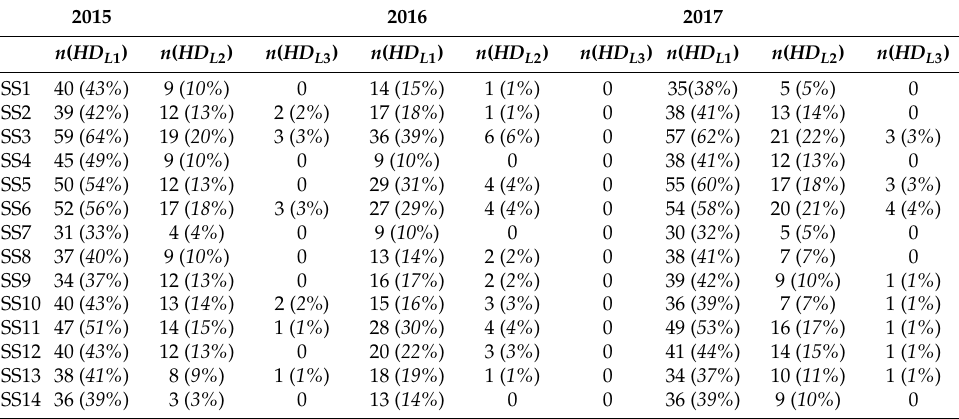
Table 2. Hot Days (in parenthesis, in italic, the percentage calculated in summer, 92 sampling days). Legend: n ( HD L 1 ) = number of Hot Days of the first level; n ( HD L 2 ) = number of Hot Days of the second level; n ( HD L 3 ) = number of Hot Days of the third level.